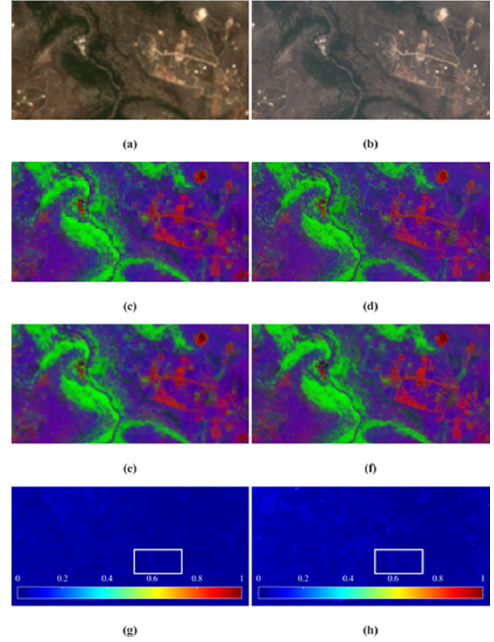
Figure 13. Zoom-in on the abundance fraction maps for three dominant EMs in the selected area for Test 2. ( a , b ) present RGB composites of the Venus 10 m and Venus 5 m images, respectively. ( c , d ) present corresponding fraction maps as obtained using the original spectral images with LSR 10 m and HSR 5 m (used as GT), respectively. ( e , f ) present corresponding fraction maps with HSR 5 m, as obtained using the image retrieved by the PSQ-PS method, and as obtained by the proposed fusion method DFuSIAL, respectively. ( g , h ) present full MAE maps of the fractions obtained by the PS and DFuSIAL methods, respectively. The white rectangle in ( g , h ) marks the selected zoom-in area.